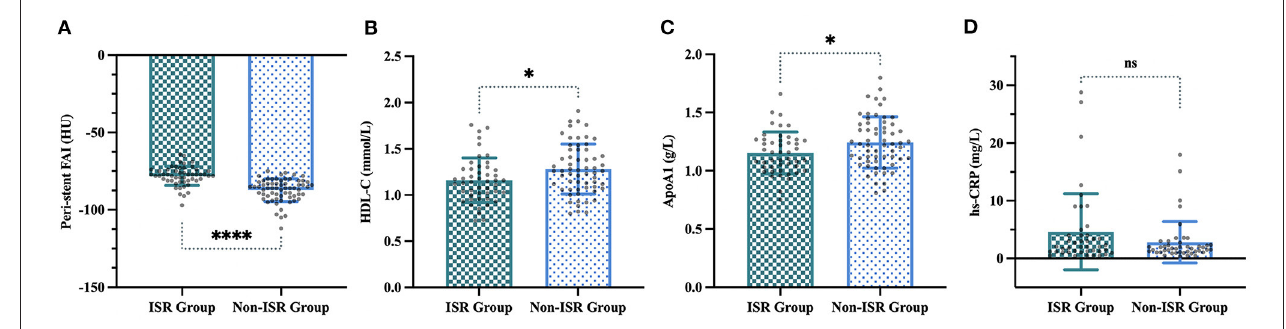
FIGURE 4 | Four variables selected by LASSO regression in the ISR and non-ISR groups. (A) Peri-stent FAI values were − 78.1 ± 6.2 HU in the ISR group compared with − 87.2 ± 7.3 HU in the non-ISR group ( p < 0.001). (B) HDL-C, (1.2 ± 0.2 mmol/L vs. 1.3 ± 0.3 mmol/L, p < 0.05). (C) ApoA1, (1.1 ± 0.2 g/L vs. 1.2 ± 0.2 g/L, p < 0.05). (D) Hs-CRP, (4.6 ± 6.6 mg/L vs. 2.8 ± 3.6 mg/L, p = 0.107). “*”, “****” and “ns” indicate p < 0.05, p < 0.001 and non-significant, respectively.